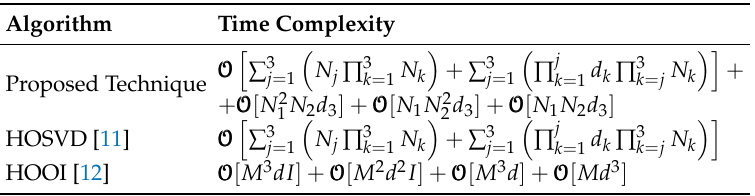
Table 7. Time complexity for the proposed approach, as well as the HOSVD and HOOI low-rank approximation techniques.